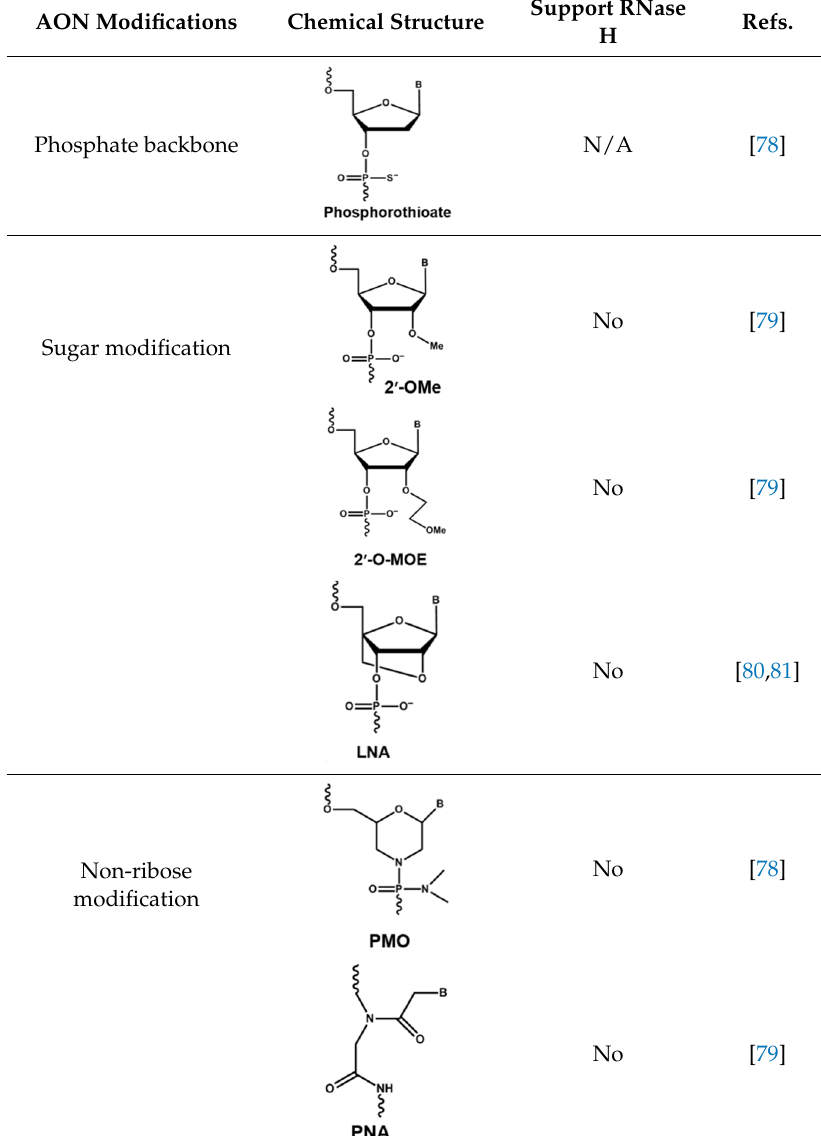
Table 1. Examples of chemical modification in antisense oligonucleotides.